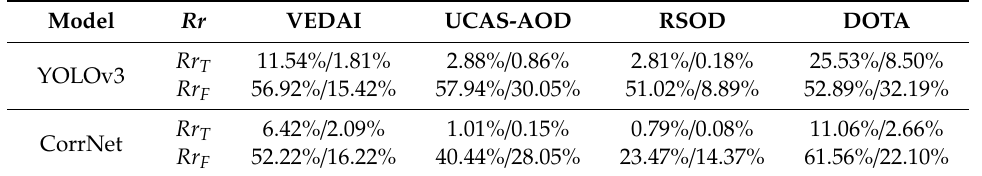
Table 4. Max / min removal rates of the true and false detection boxes for each dataset in di ff erent detection